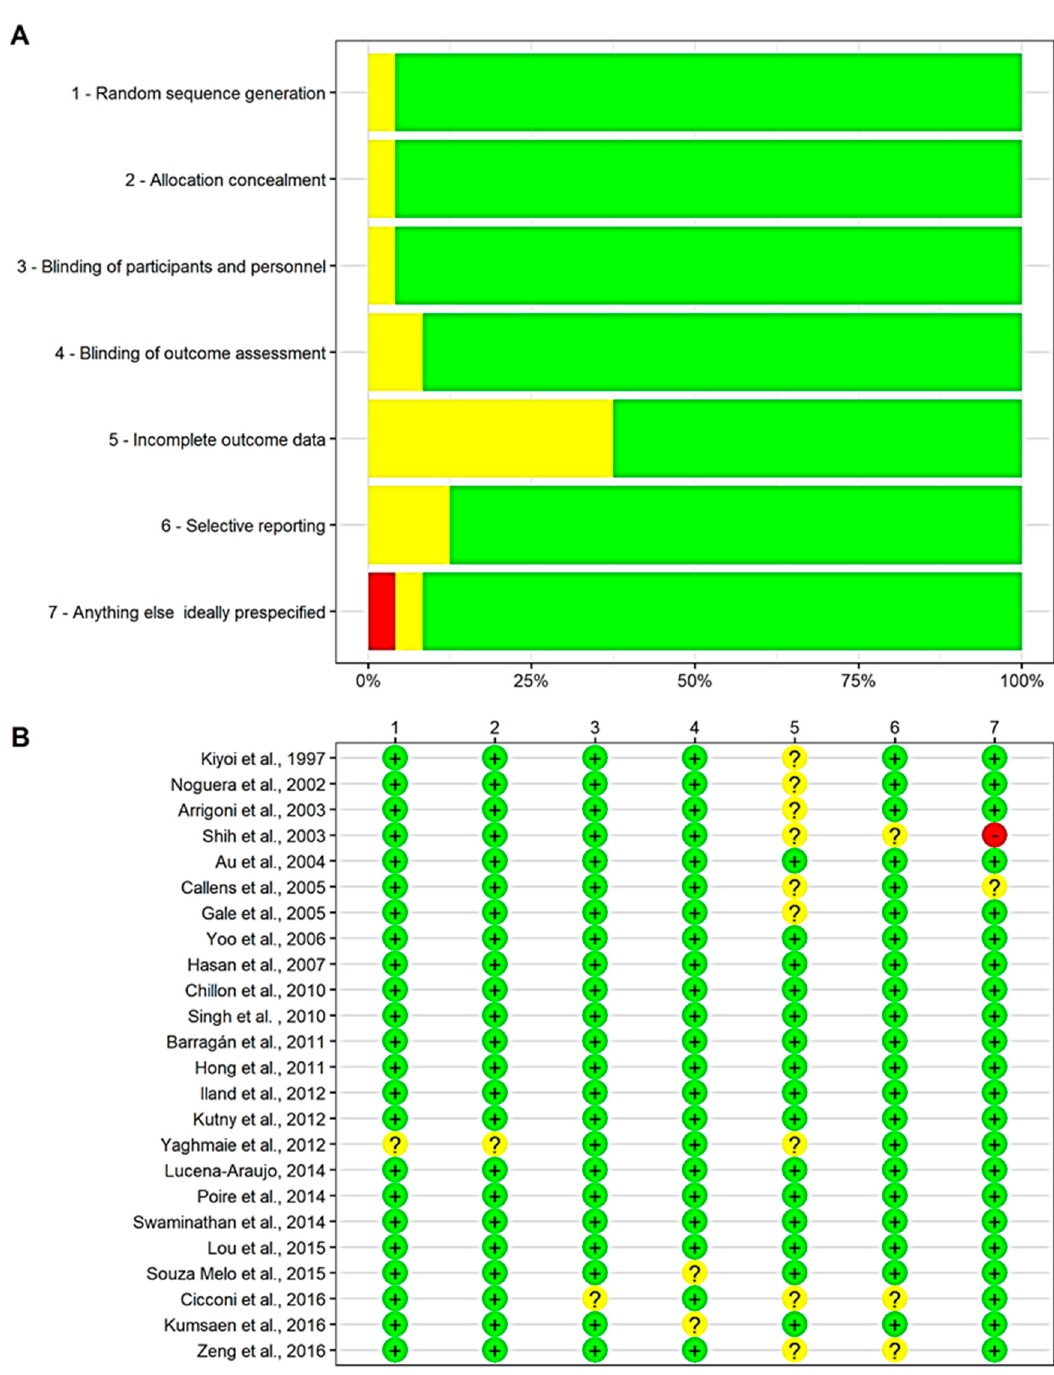
Figure 2. Risk of bias evaluation of each included study. ( A ) Risk of bias graph; ( B ) Risk of bias summary.